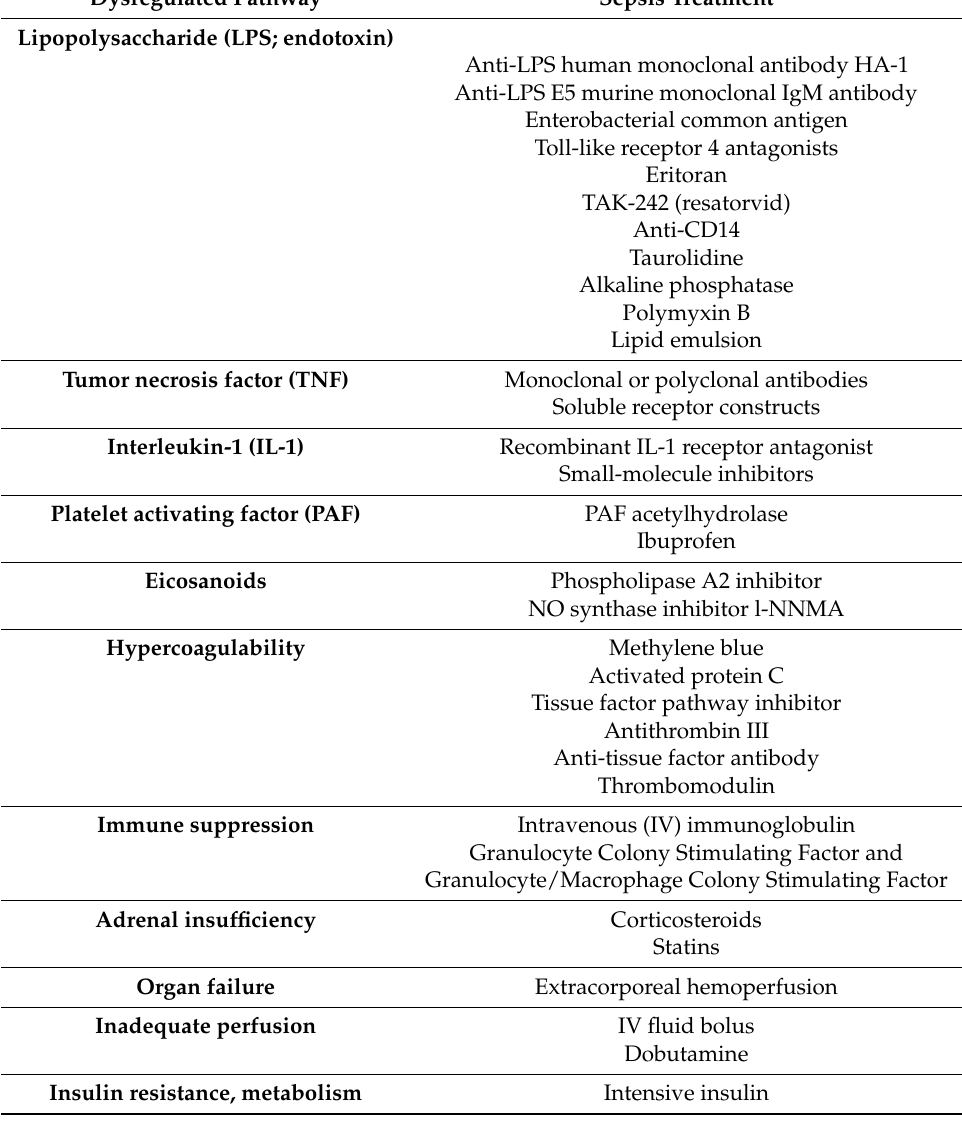
Table 1. Targets of treatment in sepsis, adapted from